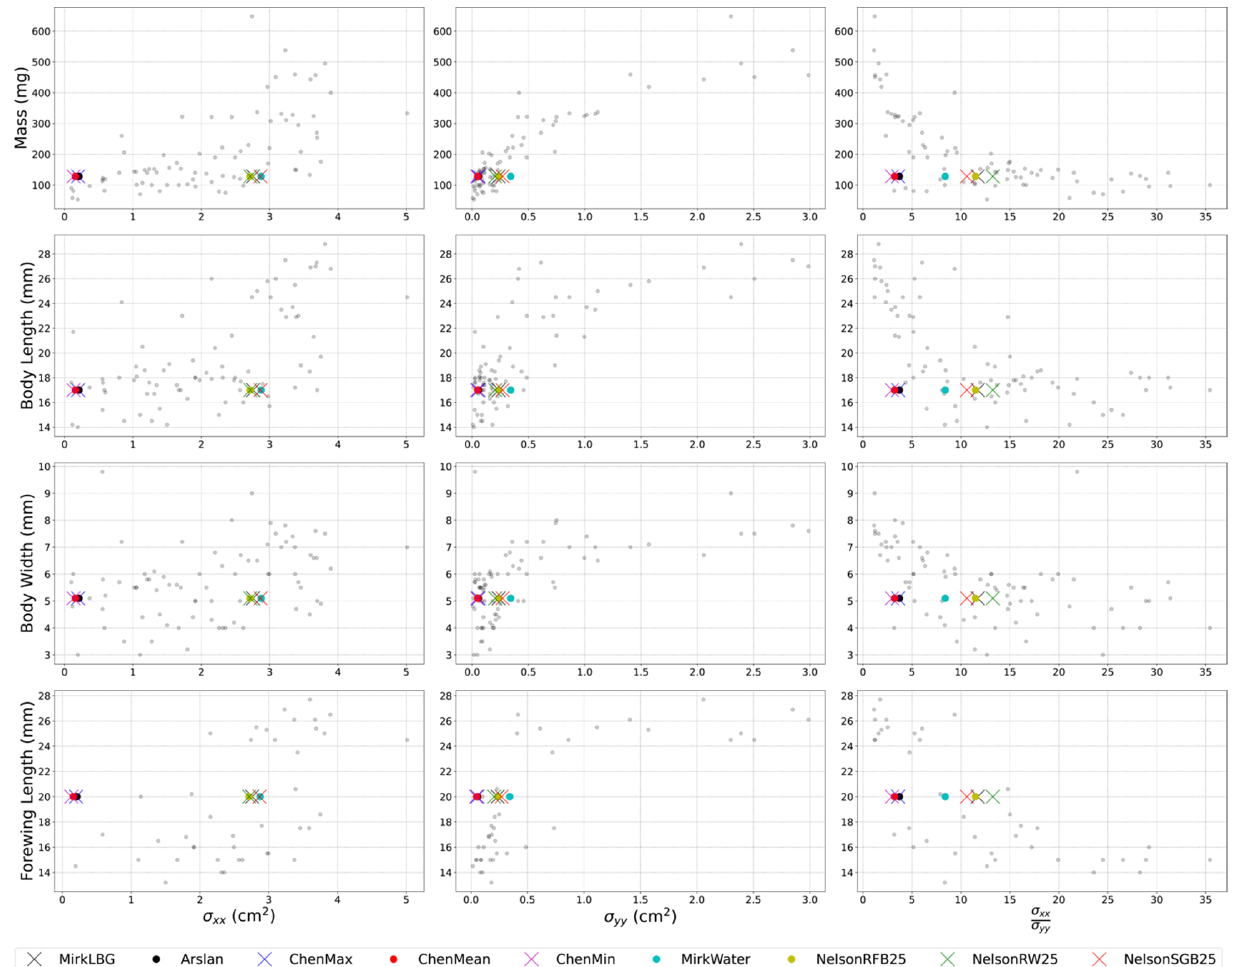
Figure 12. Comparison of a series of simulations of the Body Only model (Figure 4d) where the only change was the internal dielectric constant. The grey data points represent the along-body ( σ xx ) and cross-body ( σ yy ) RCS values and their ratio ( σ xx / σ yy ) versus the corresponding morphological attributes reported by Drake et al. [19] for noctuid moths.